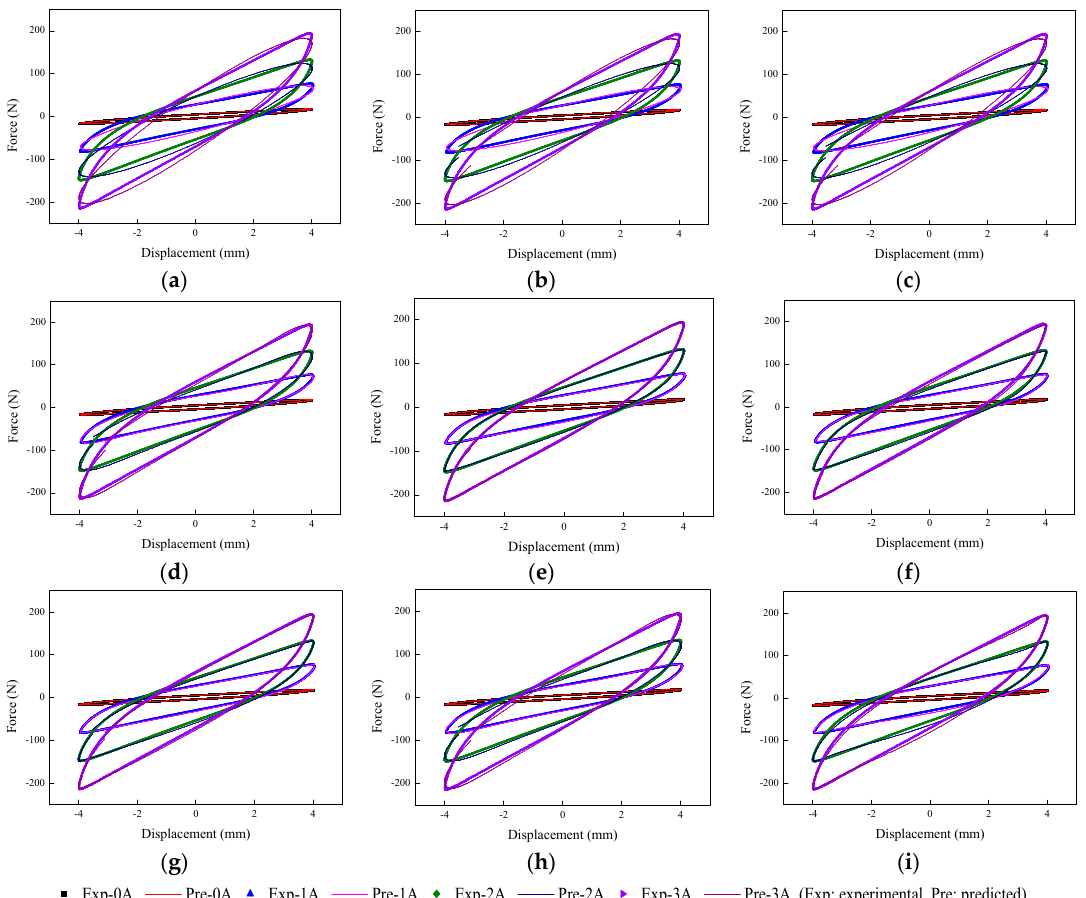
Figure 16. Comparisons of force–displacement responses between experimental results and model predictions when the loading frequency and amplitude are 0.1 Hz and 4 mm. ( a ) Kelvin–Voigt model, ( b ) four-parameter viscoelastic model, ( c ) rheological model, ( d ) BW model, ( e ) improved BW model, ( f ) Dahl model, ( g ) improved LuGre friction model, ( h ) strain stiffening model, and ( i ) hyperbolic hysteresis model.